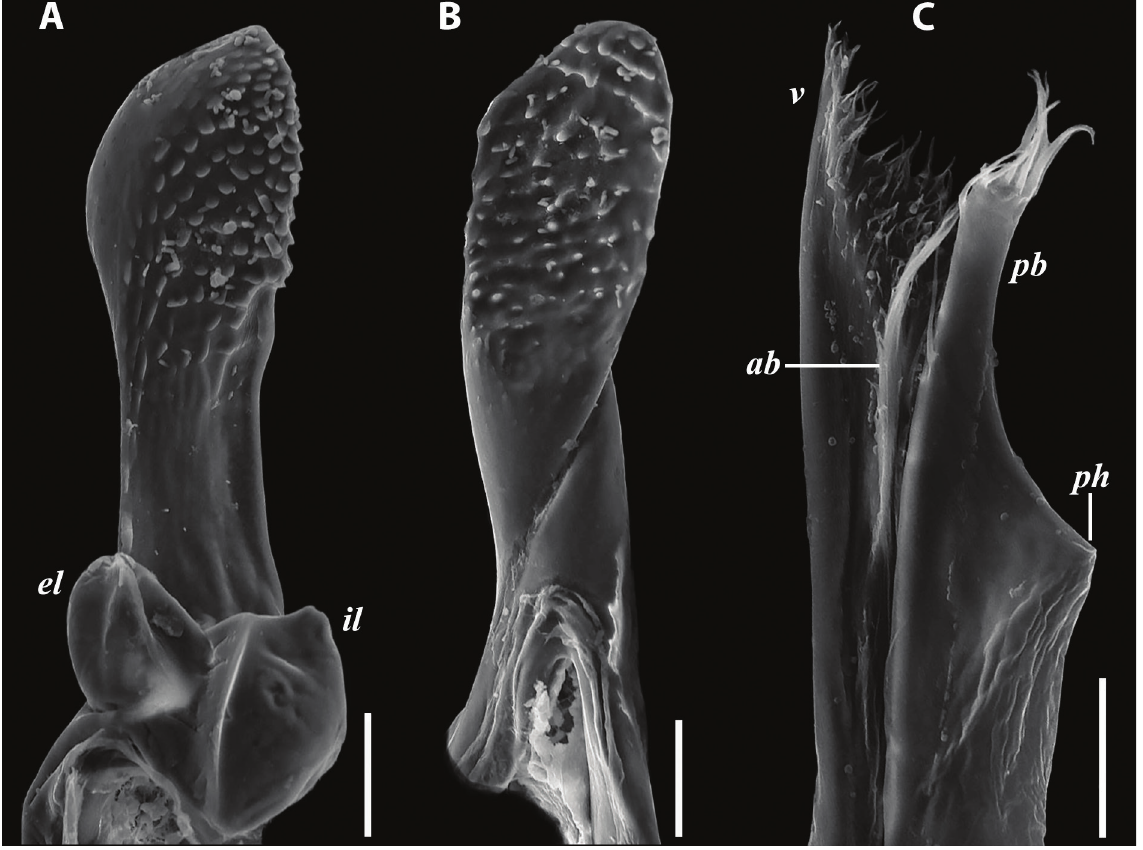
Fig. 6. Stygiiulus gentianae (Strasser, 1971) comb. et stat. nov., ♂ from Grotta [cave] della Vecchia Diga (NHMD). A . Right promere, caudal view. B . Right mesomere, oral view. C . Distal part of left opisthomere, mesal view. Abbreviations: ab = anterior branch of solenomere; el = external lobe; il = internal lobe; pb = posterior branch of solenomere; ph = posterior hump; v = velum. Scale bars = 0.05